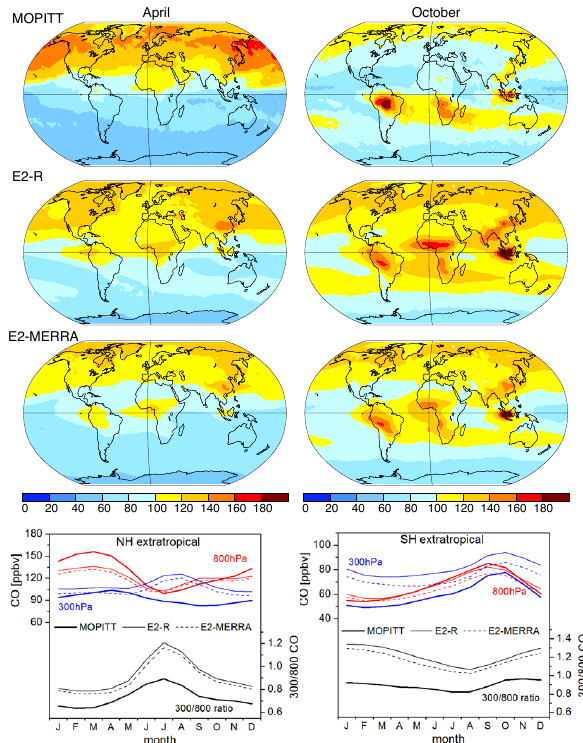
Fig. 10. Mid-tropospheric CO (ppb) in MOPITT observations and in the E2-R and E2-MERRA simulations for 2005–2009 (top three rows). Values are given for the broad retrieval level centered near 500hPa. Seasonal cycle of CO (ppb) in MOPITT observations and the models for the retrieval levels centered at 300 and 800hPa and their ratio in the extratropics (bottom